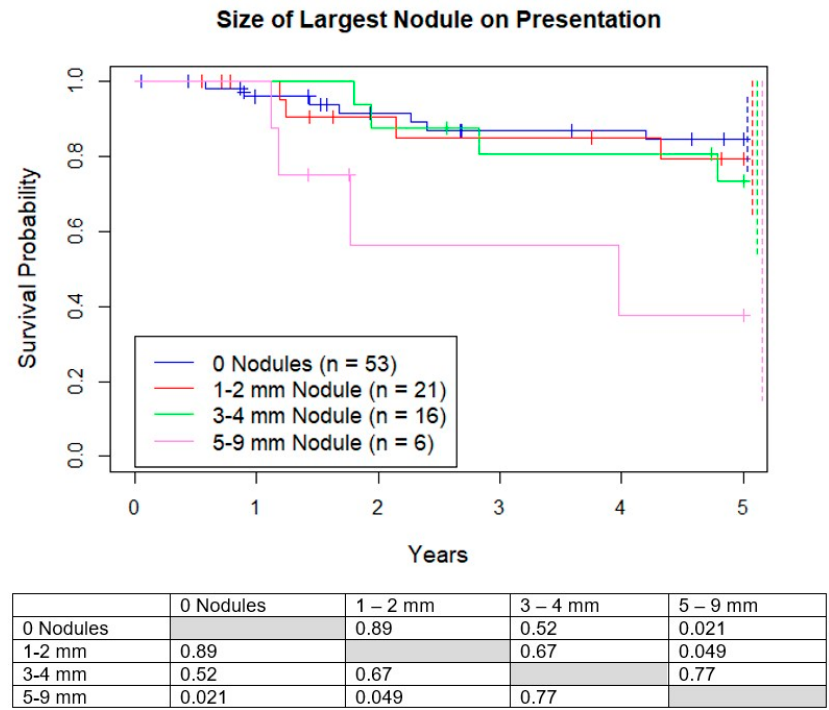
Figure 3. Kaplan–Meier curves demonstrating survival probability vs. years. Groups are separated by size of largest micronodule on presentation. Dotted lines represent 95% confidence intervals for respective color.